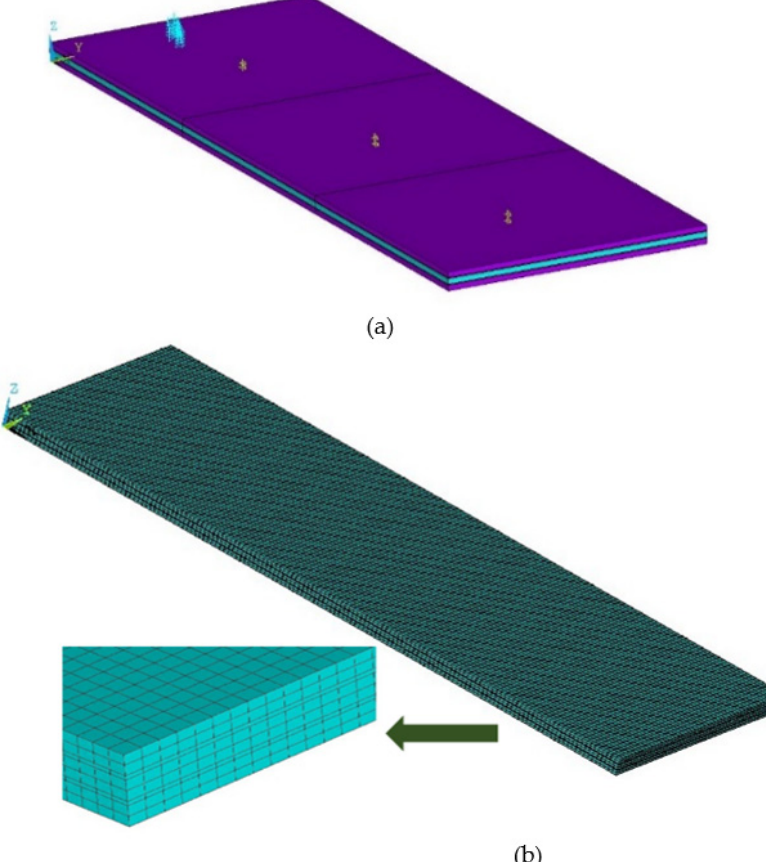
Figure 8. ( a ) FE model and ( b ) full mesh with zoomed partial view.